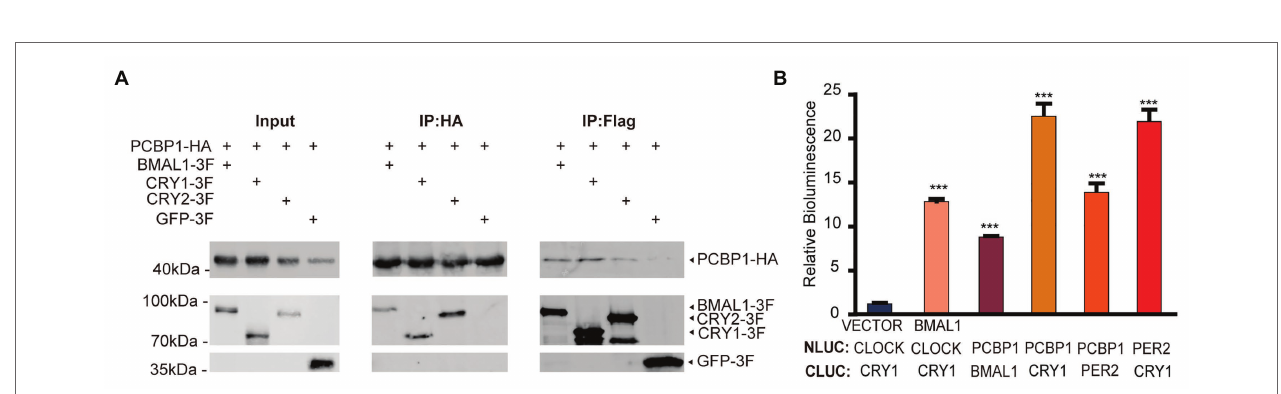
FIGURE 2 | PCBP1 enhances the interaction of CRY1 with the CLOCK/BMAL1 complex. (A) schematic diagram of luciferase complementation assay. (B) Luciferase complementation assay was used to determine the interaction among CLOCK, BMAL1, and CRY1. (C) PCBP1 could not enhance the complex formation of CLOCK-BMAL1 or CLOCK-CRY1, but the formation of CLOCK-BMAL1-CRY1. (D) The complex formation of CLOCK-BMAL1-CRY1 in siBMAL1, siCRY1, or siPCBP1 cells. (E) The knockdown efficiency of siPCBP1#1 and #2 in 293 T cells. All data are presented as the mean ± SEM from at least three independent experiments. Statistical significance was determined using one-way ANOVA (C–E) or two-way ANOVA followed by Bonferroni’s multiple comparisons test (B) . ( n ≥ 3, ** p < 0.01, and *** p < 0.001).